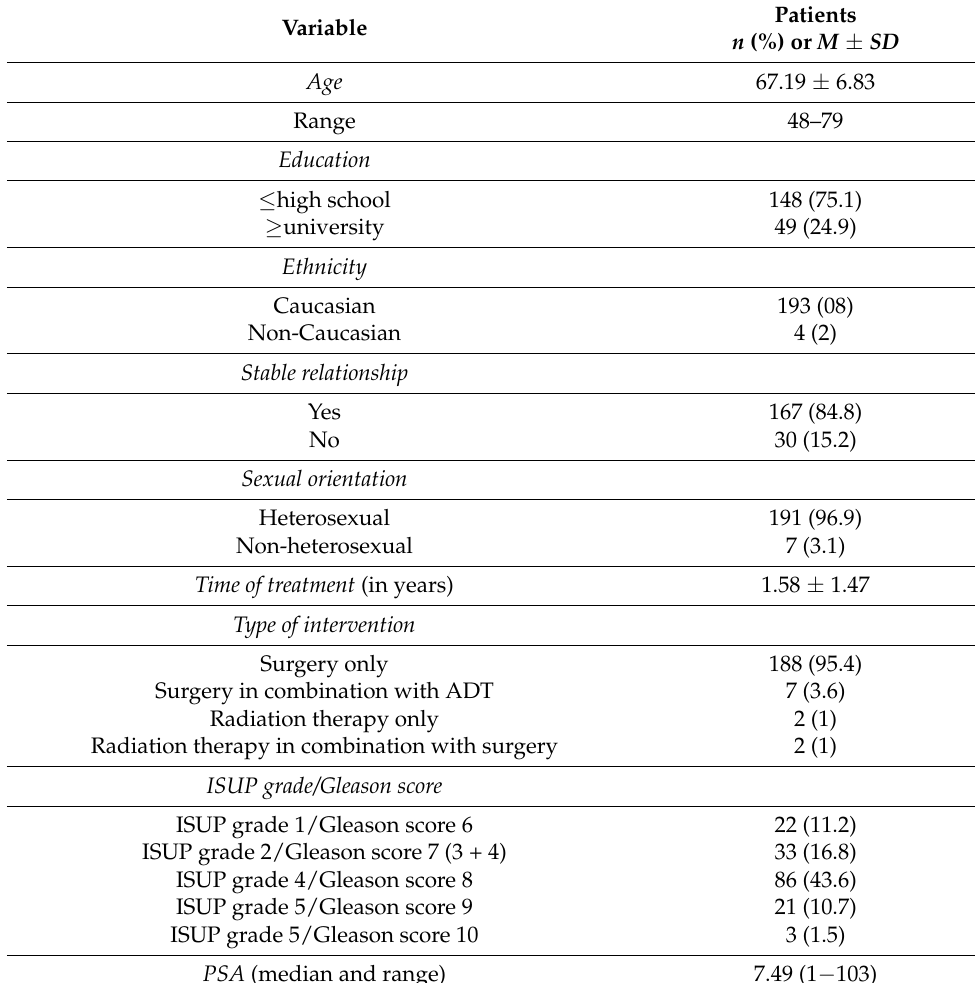
Table 1. Socio-demographic and clinical characteristics of PCa patients ( n = 197).